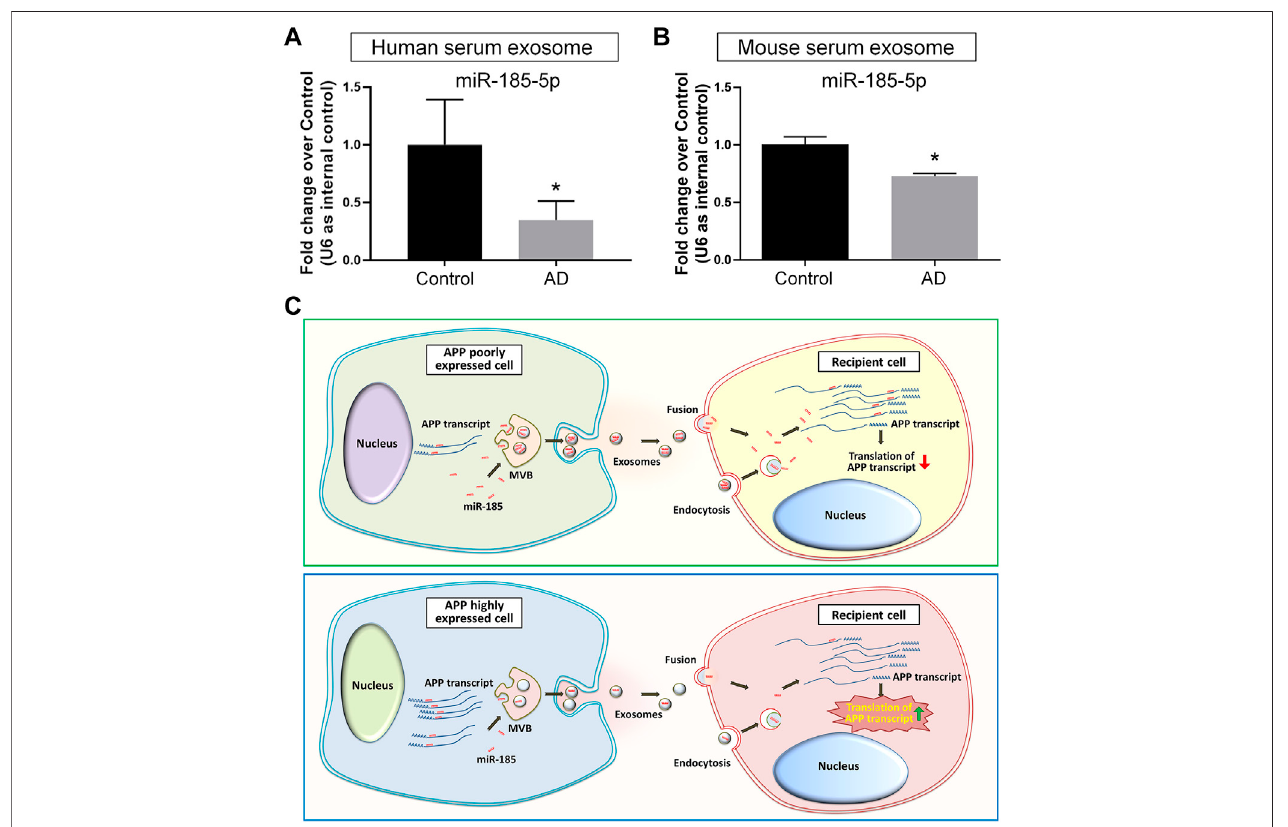
FIGURE7| SerumexosomalmiR-185-5pislowerinADpatientsandmicethanhealthycontrols. (A) HumanserumexosomeswereisolatedfromthreeADpatients and three healthy donors. The levels of miR-185-5p in exosomes were determined by RT-qPCR. (B) Mouse serum exosomes were isolated from three APP/PS1 mice and three control mice. The levels of miR-185-5p in exosomes were determined by RT-qPCR. (C) A schematic representation of exosome-mediated APP regulation. Upper panel: in normal conditions, the low levels of endogenous APP transcripts in normal neuronal cells result in high levels of free intracellular miR-185-5p. Consequently, more miR-185-5p can be loaded into exosomes and delivered to recipient cells via exosomes for maintaining APP expression at a low level in recipient cells. Lower panel: in pathological conditions, the expression levels of APP transcripts are abnormally elevated in neuronal cells. Excessive APP transcripts bind to more miR-185-5p, reducing free miR-185-5p intracellularly and leading to less miR-185-5p that can be loaded into exosomes. Exosomes with less miR-185-5p fail to suppress APP expression in recipient cells, causing uncontrolled APP expression. Data were represented as mean ± s. d. * denotes p < 0.05.